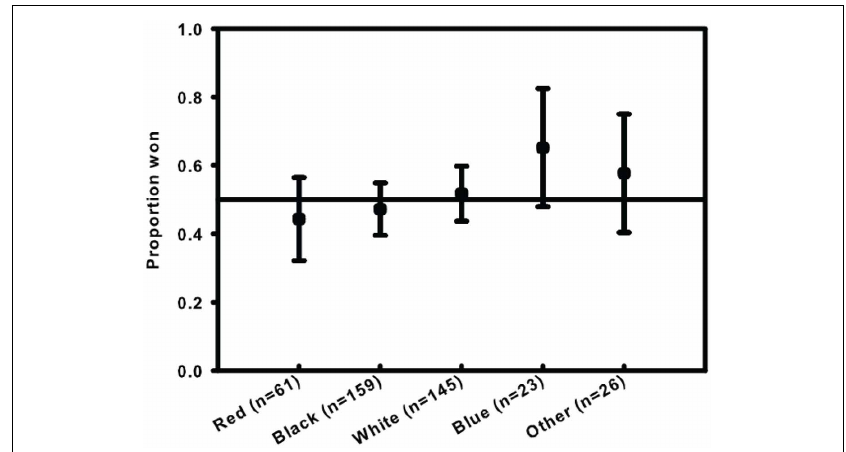
FIGURE 1 | Proportion of UFC fights won by color of shorts. Ninety-five percent confidence intervals are based on Agresti–Coull method. Reference line is 0.5.